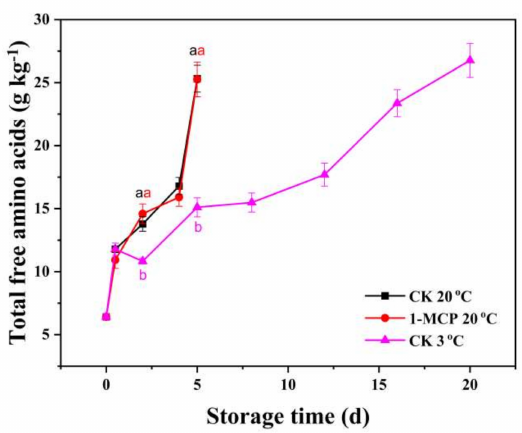
Figure 5. The content of total free amino acids of 1-MCP treated and untreated chives during storage at 20 ◦ C and 3 ◦ C. The content of free amino acids in 1-MCP treated chives stored at 3 ◦ C was not determined. Data are expressed as the mean of triplicate samples. Vertical bars represent the standard errors of the means. The different letters of each treatment indicate a difference among the chives